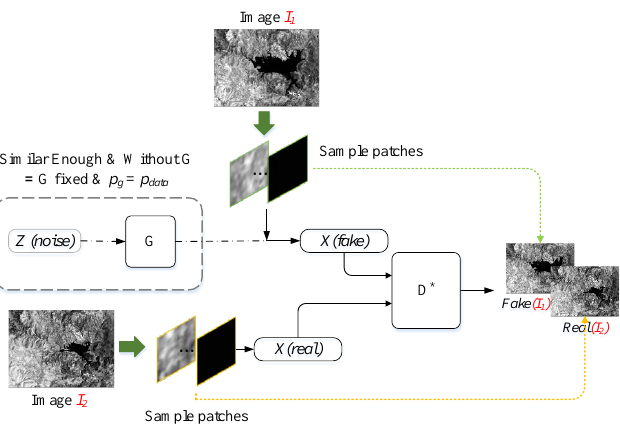
Figure 4. The architecture of temporal prediction that asks the D to identify sample patches centered on pixels between image resource, i.e., the fake ( I 1 ) or the real ( I 2 ) . The G’s section in the dashed frame has not been used. In contrast to GAN, when we train such model, which is equivalent to the case we optimize the D becoming optimal for a fixed G and p g = p data